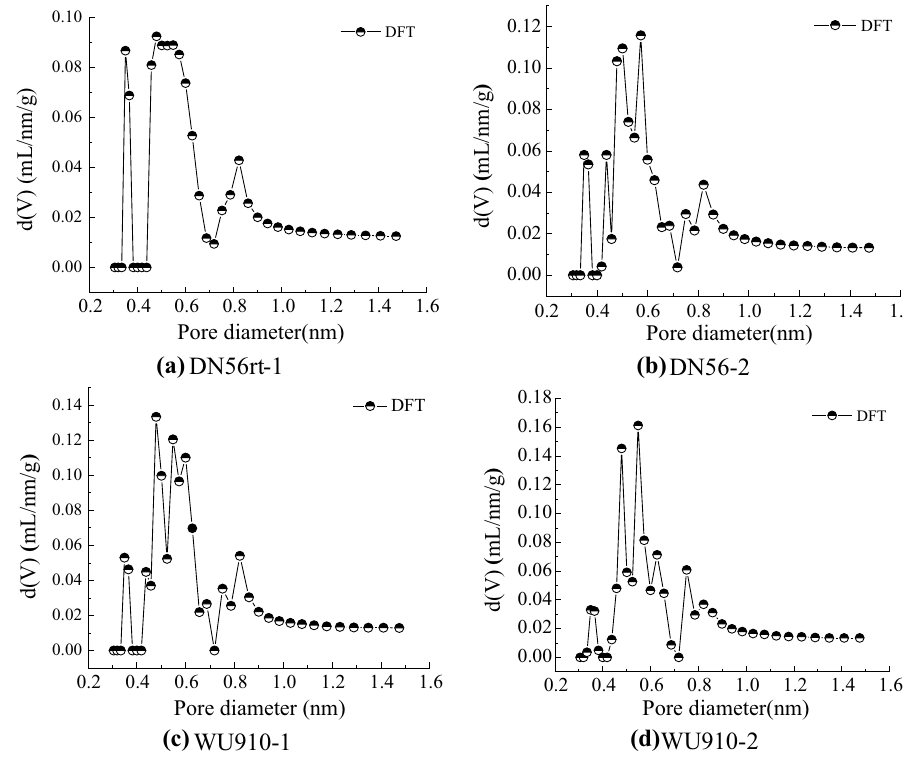
Fig. 6 Pore size distributions by CO 2 -adsorption